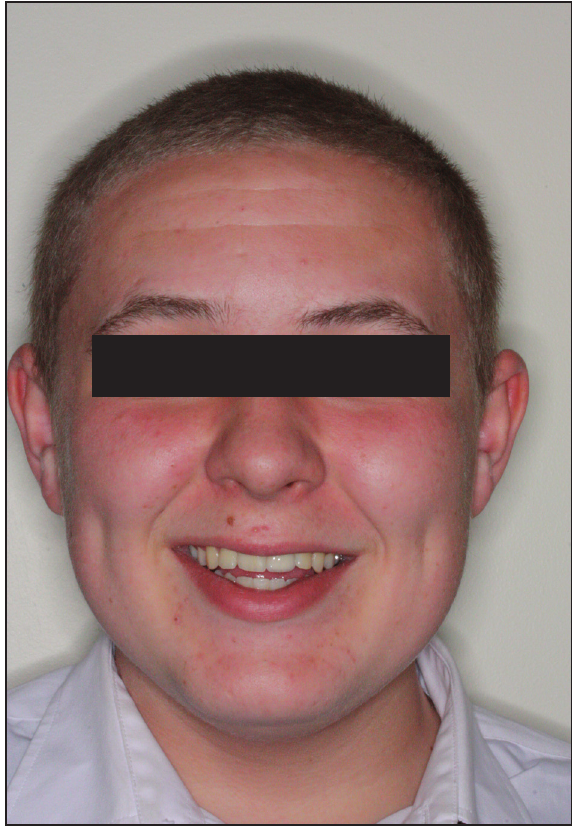
Figure 11. Post-treatment extra-oral photograph. Note the spontaneous smile with display of all upper anterior